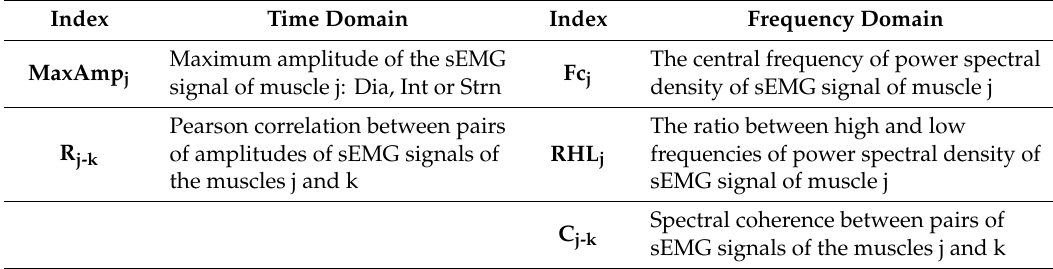
Table 1. sEMG indexes in time and frequency domains for each one of the recorded muscles, diaphragm (Dia), intercostal (Int) and sternocleidomastoid (Strn). Index Time Domain Index Frequency Domain Maximum amplitude of the sEMG MaxAmp j signal of muscle j: Dia, Int or Strn Pearson correlation between pairs R j-k of amplitudes of sEMG signals of the muscles j and k